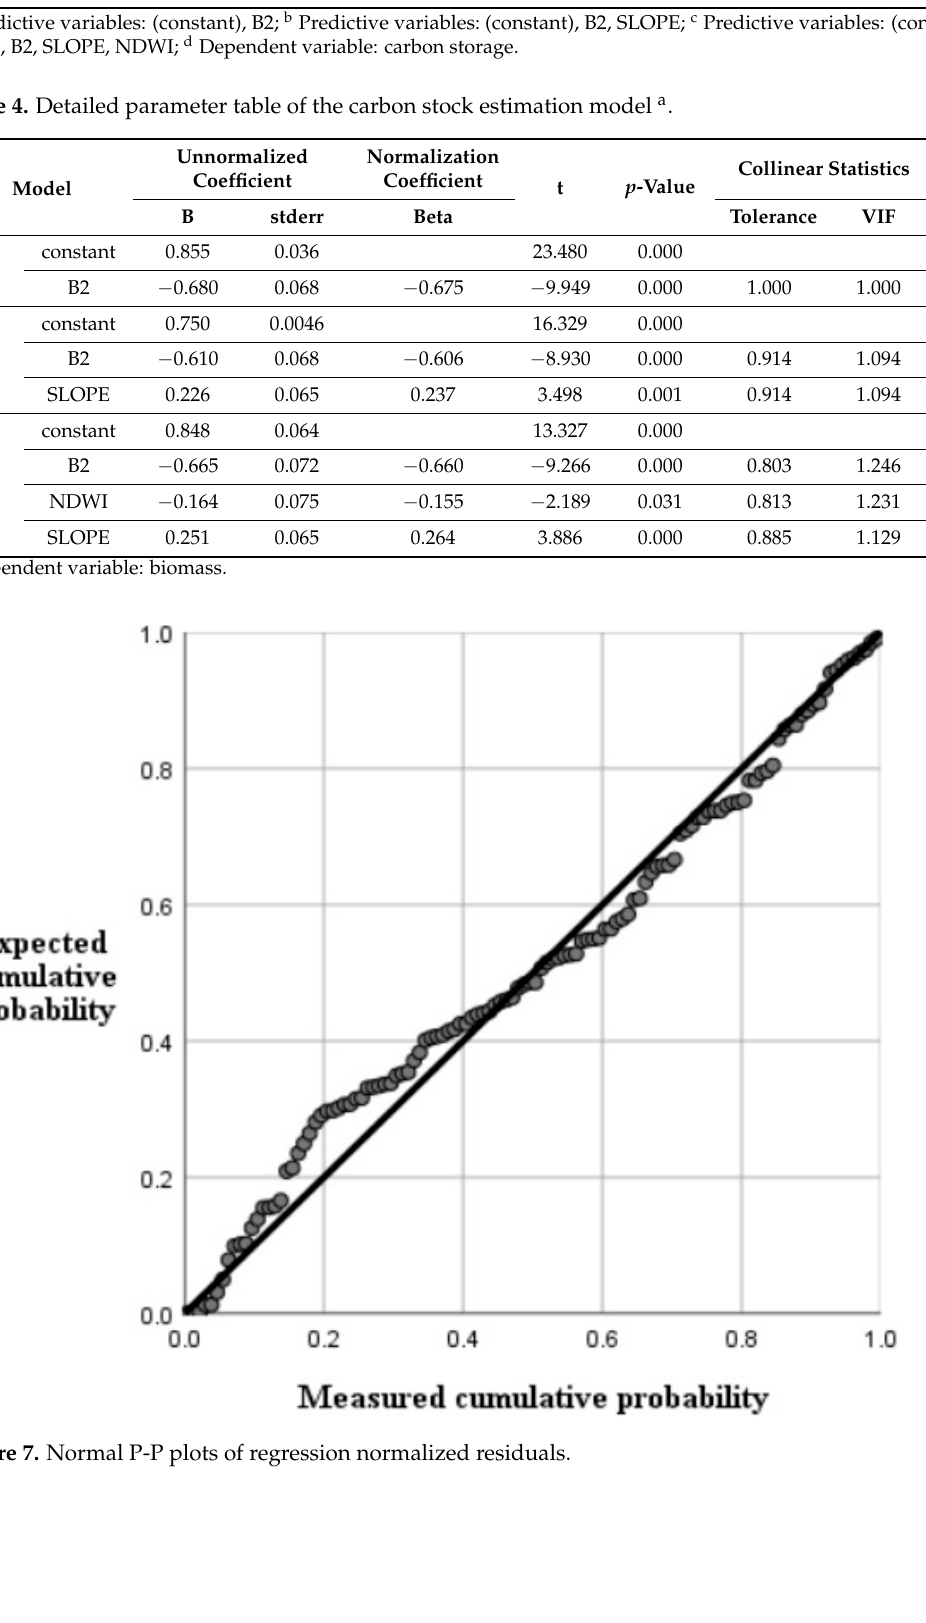
Table 4. Detailed parameter table of the carbon stock estimation model a .